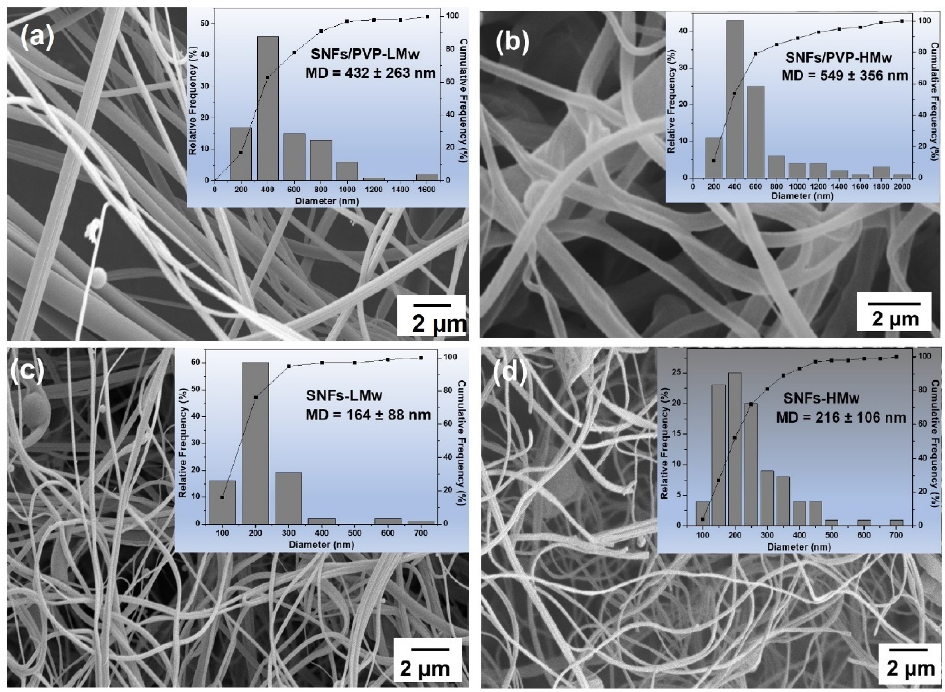
Figure 1. SEM images and distribution of the diameter (inset) of: ( a ) SNFs/PVP-LMw, ( b ) SNFs/PVP-HMw, and ( c ) SNFs-LMw and ( d ) SNFs-HMw.